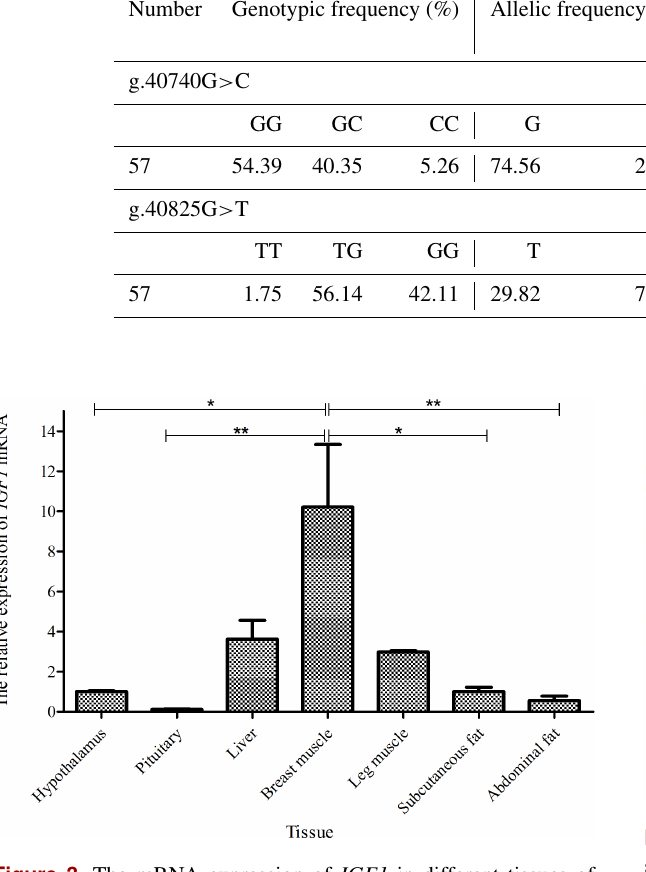
Figure 3. The mRNA expression of IGF1 in different tissues of a 0-week-old Shitou goose. The ∗ symbol represents a significant difference ( P< 0 . 05). The ∗∗ symbol represents a very significant difference ( P< 0 . 01). The same applies to Figs. 4 to 7. Values are shown as the mean ± SD ( n = 3); the same applies to Figs. 4 to 7.